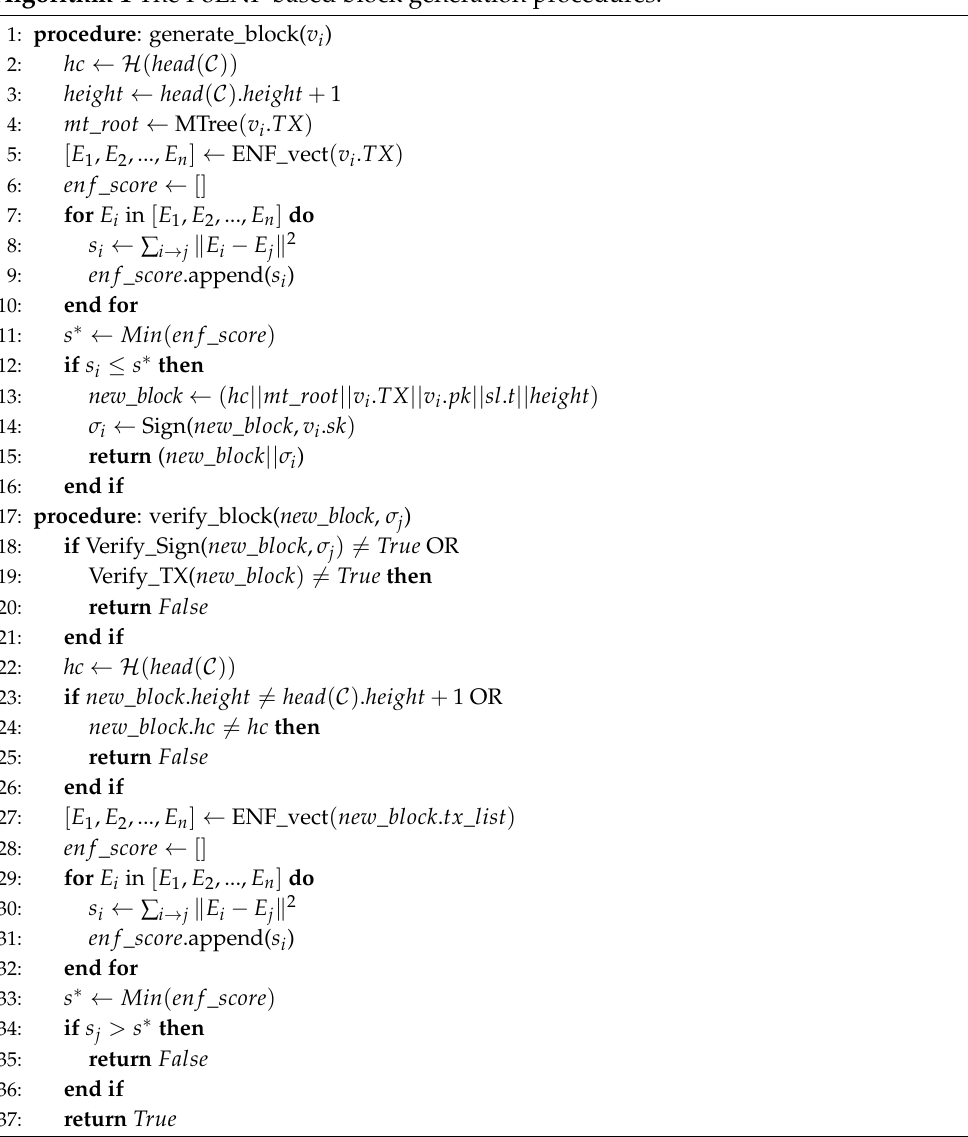
Algorithm 1 The PoENF-based block generation